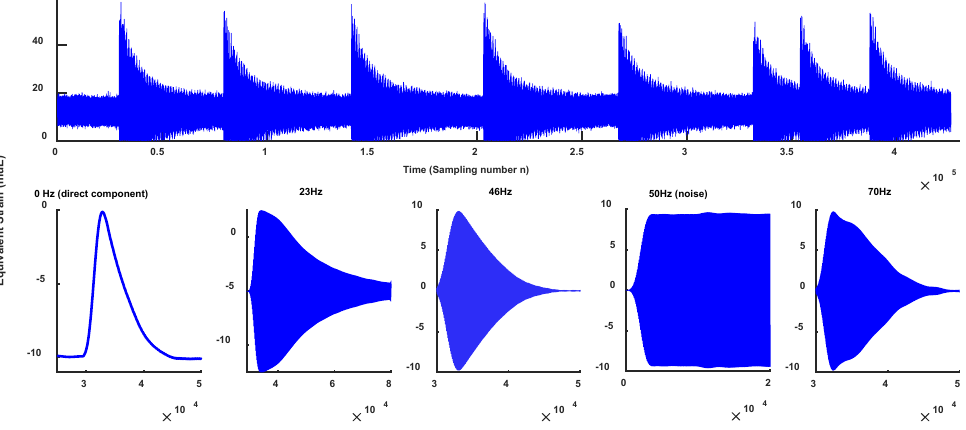
Taking Response 4 as an example, the result is shown in Figure 11.